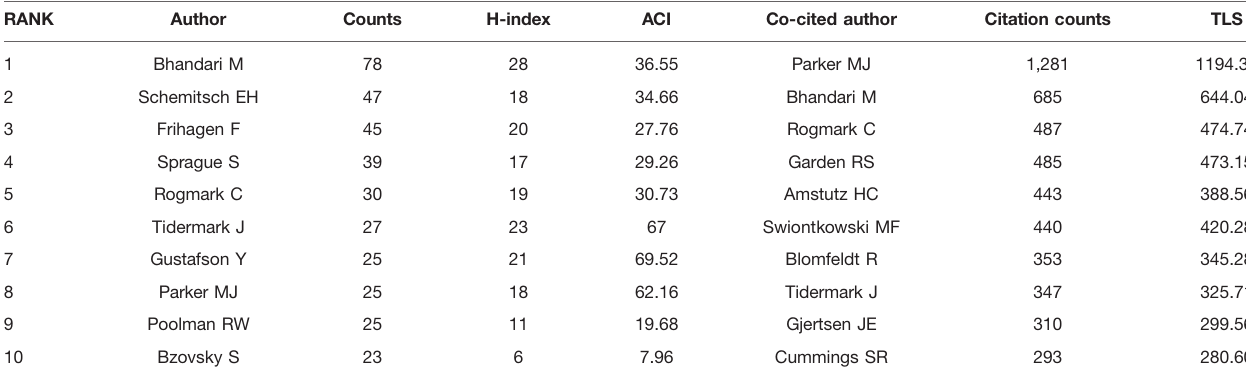
TABLE 2 | The top 10 most productive and co-cited authors in FNF